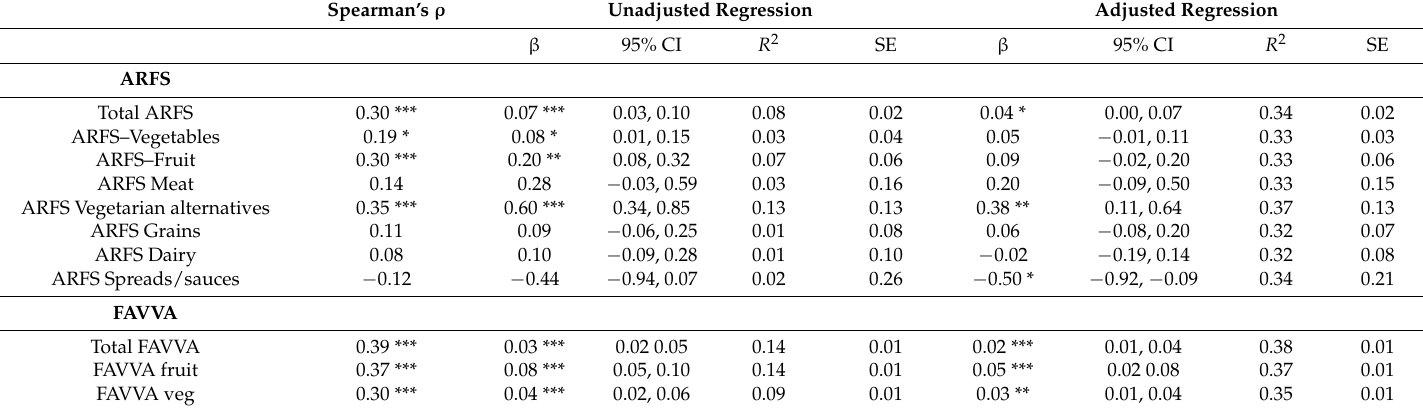
Table 2. Spearman’s correlations and regression analyses (unadjusted and adjusted) between participant ( n = 148) skin yellowness (overall b*) and diet index.